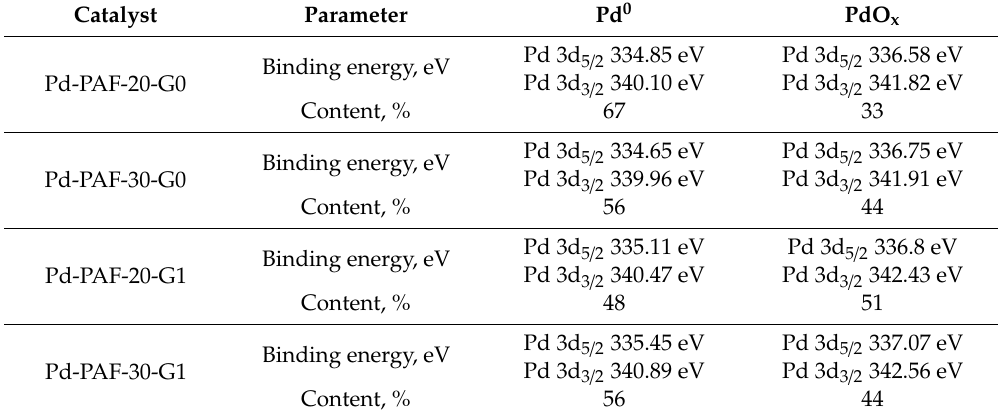
Figure 5. X-Ray photoelectron spectroscopy (XPS) measurements for obtained palladium catalysts. Table 5. Peak parameters for XPS spectra of obtained palladium catalysts.